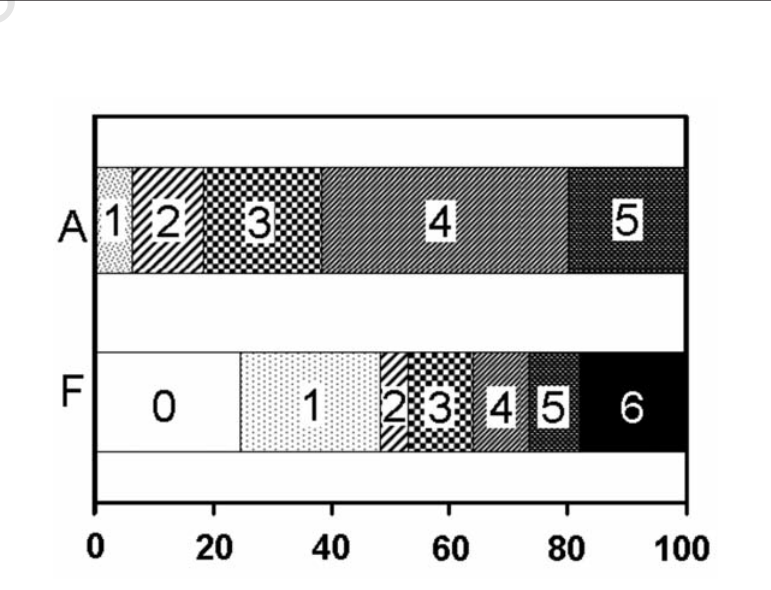
Figure 3. Neurological impairment of the 192 patients as assessed with the modified Rankin Scale on admission before thrombolysis (A) and at follow up (F). Note that half of the patients had no only or little impairment at follow up.